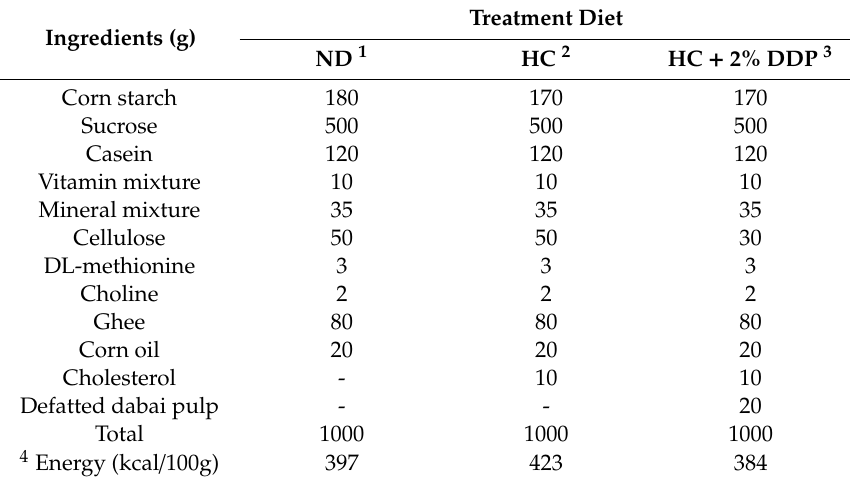
Table 1. Treatment